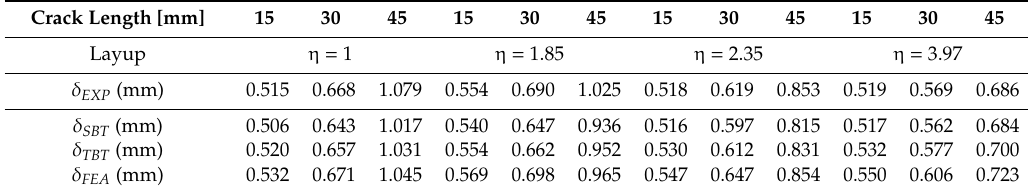
Table 1. Results of the AENF specimen deflection at mid-span during loading.